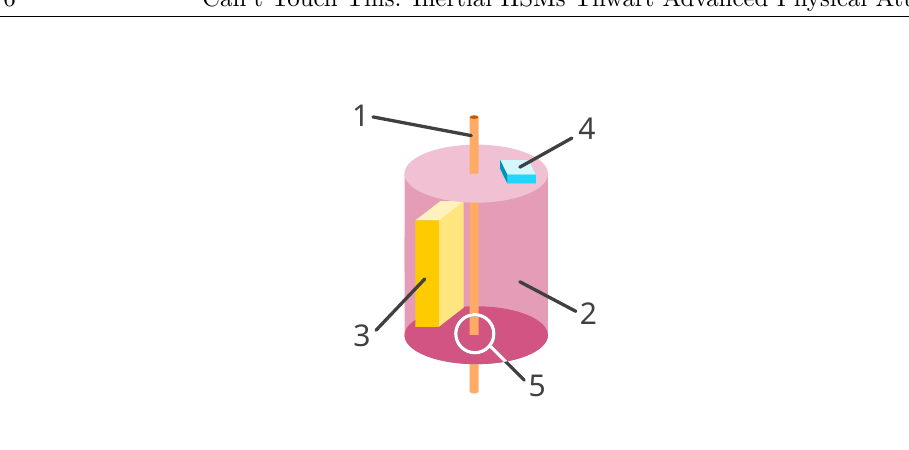
Figure 2: Concept of a simple spinning Inertial HSM. 1 - Shaft. 2 - Security mesh. 3 - Payload. 4 - Accelerometer. 5 - Shaft penetrating security